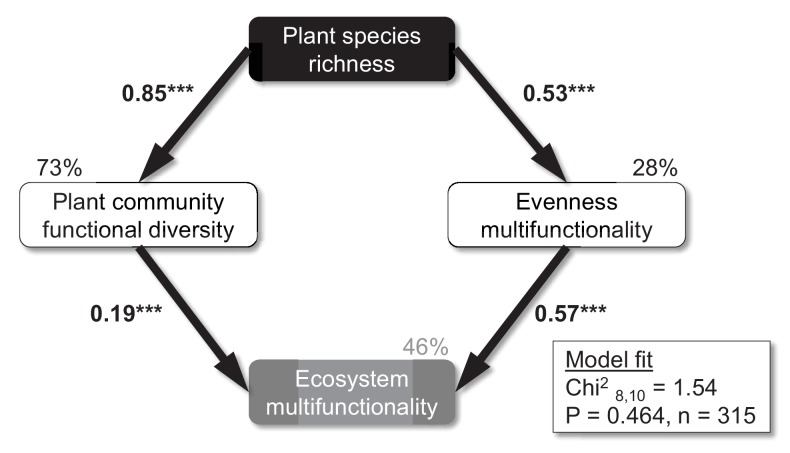
Mechanisms underlying plant diversity effects on ecosystem multifunctionality.Structural equation model on the effects of sown plant species richness on the functional diversity of the plant community (functional dispersion), evenness of multiple functions, and ecosystem multifunctionality. Numbers on arrows are standardized path coefficients. All paths retained in this final model were significant (p<0.001). Percentages on boxes indicate the variance explained by the model. Modification indices were used to check if additional paths would improve the model. ***p<0.001.